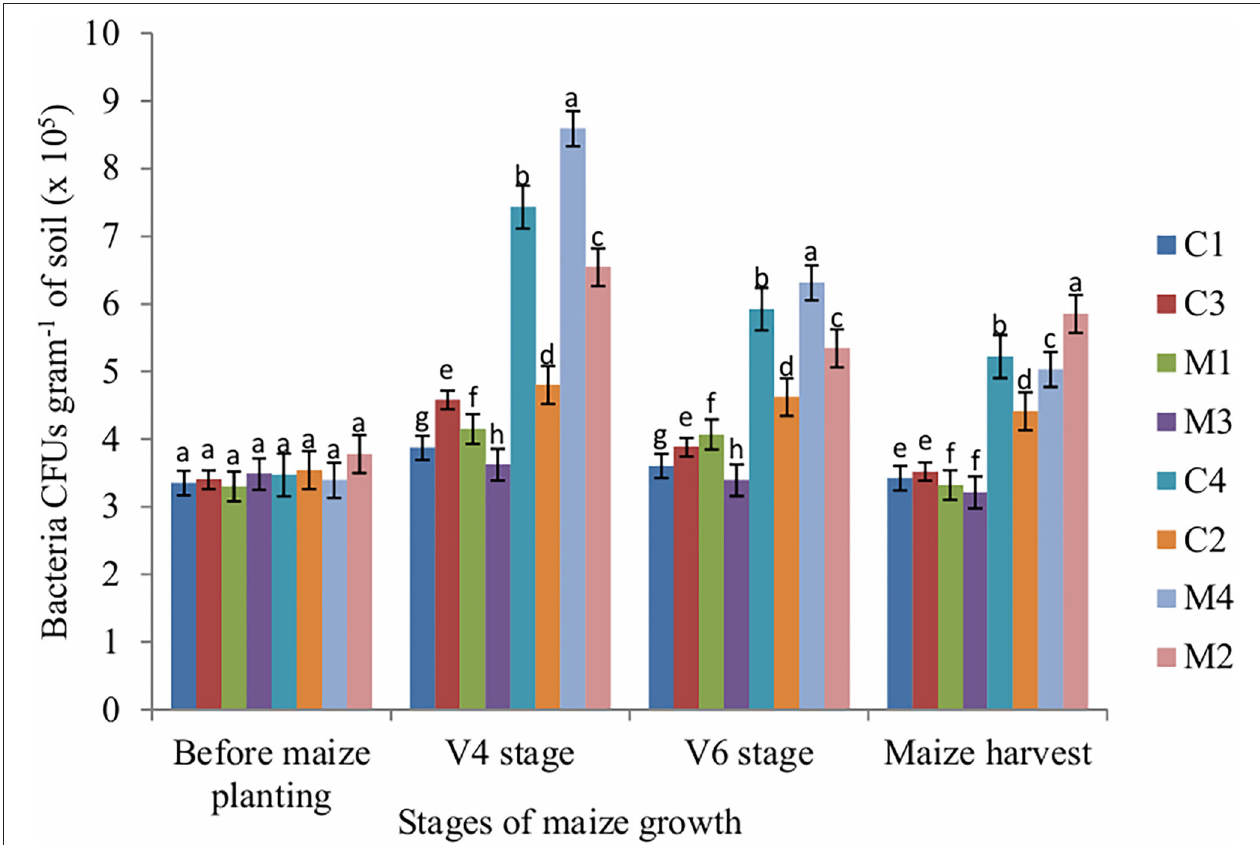
FIGURE 1 | Bacteria CFUs as influenced by tillage, mulching and inorganic fertilization. Stages of maize growth were; before maize planting: 0 days, V4 stage: 22 days, V6 stage: 63 days, and maize harvest stage: 147 days. Vertical bars represent means and whiskers – standard errors. C1, Conventional tillage + mulch + NPK fertilizer treatment; C2, Conventional tillage + no mulch + no NPK fertilizer treatment; C3, Conventional tillage + no mulch + NPK fertilizer treatment; C4, Conventional tillage + mulch + no NPK fertilizer treatment; M4, Minimum tillage + mulch + no NPK fertilizer treatment; M2, Minimum tillage + no mulch + no NPK fertilizer treatment; M3, Minimum tillage + no mulch + NPK fertilizer treatment; M1, Minimum tillage + mulch + NPK fertilizer treatment. Different letters indicate significant differences at P < 0.05 (Tukey’s HSD test).